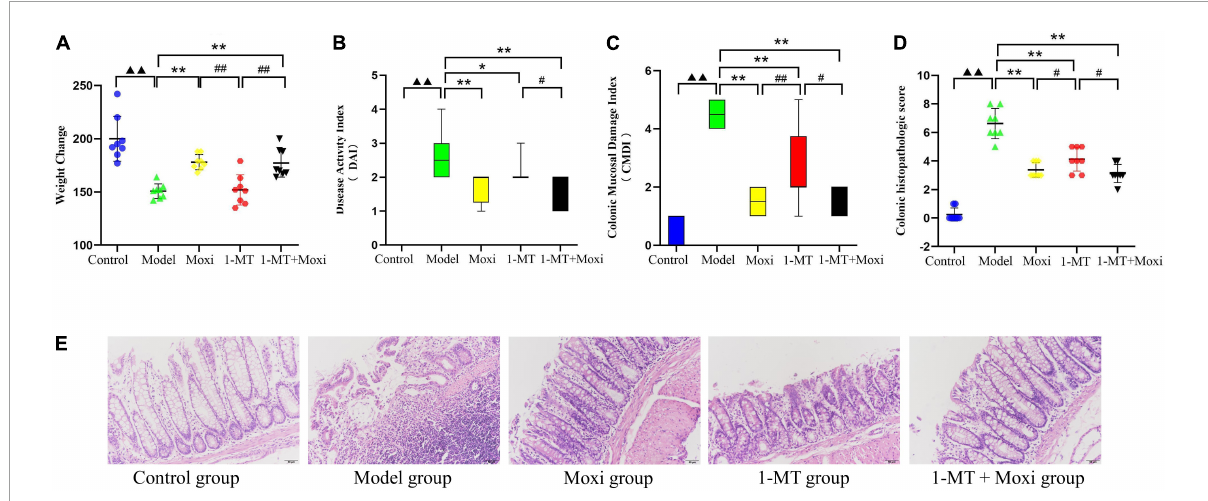
FIGURE5 Effects of moxibustion, 1-MT, or a combination of both on weight gain and improvement of intestinal inflammation levels. (A) Change in body weight, (B) Disease activity index (DAI) score, (C) Colonic Mucosal Damage Index (CMDI) score, and (D) Colonic histopathologic score. (E) Hematoxylin-eosin (HE)-stained sections of colon tissue of rats in each group. n = 8 per group. (cid:78)(cid:78) P < 0.01 vs. control group; * P < 0.05, ** P < 0.01 vs. model group; # P < 0.05, ## P < 0.01 vs. 1-MT group.